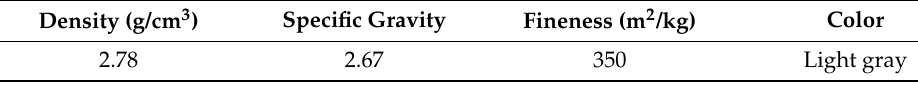
Table 3. Physical properties of WMP.